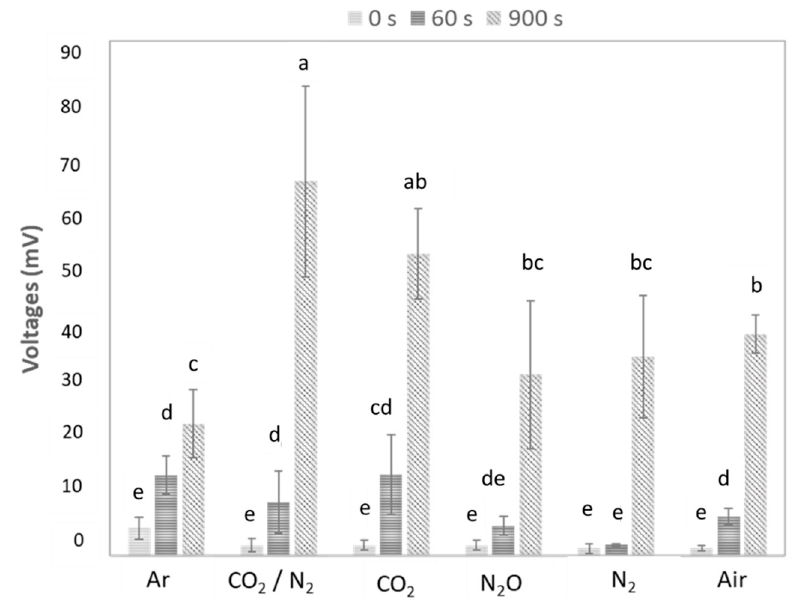
Figure 3. Summary of all pairwise comparisons for gas in the function of time (Tukey Honest Significance Difference (HSD)). Mean and standard deviation of voltages (mV). Different letters (a, b, c, d and e) indicate significant differences ( p < 0.05).